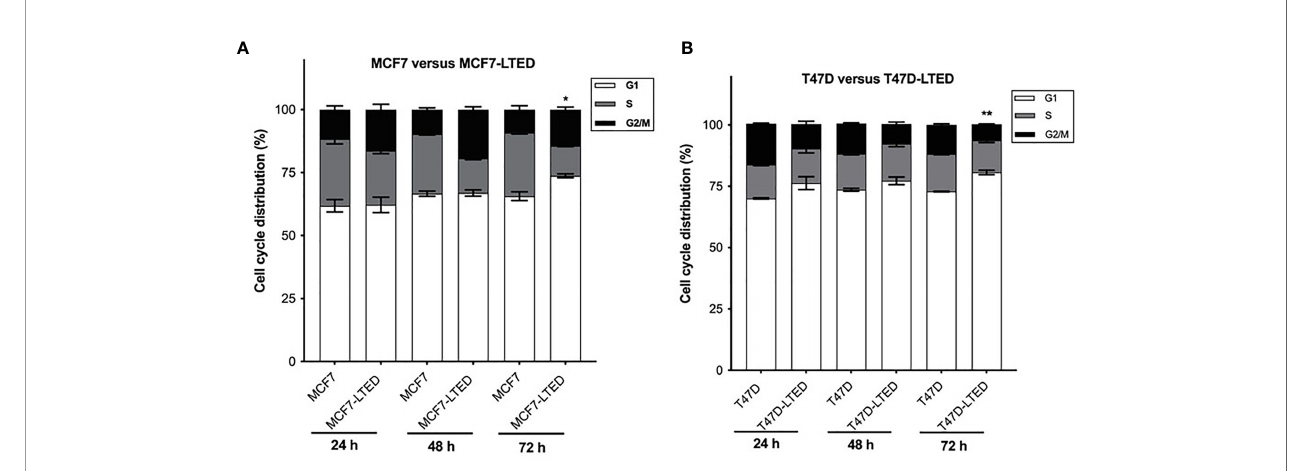
FIGURE 5 | Increased G1 cell cycle arrest in LTED derivative cells. (A, B) Parental MCF7 and T47D and their LTED derivatives were harvested at 24, 48, and 72h and measured by fl uorescence-activated cell sorting (FACS) cell cycle analysis. Bar graphs show mean percent cell cycle distribution with +SE *p < 0.05 and **p < 0.01 (Student ’ s t-test; n=3) for % cells in G1 at 72 h in respective LTED cells compared with parental